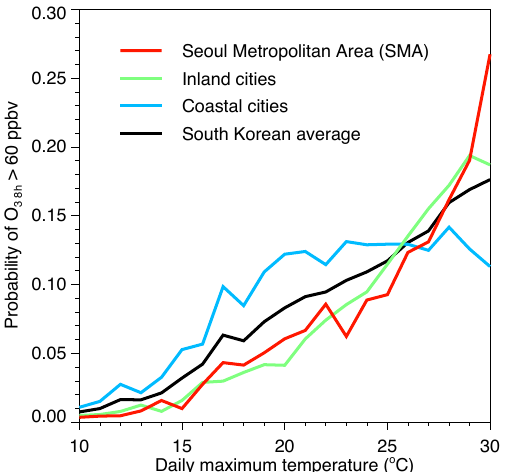
Figure 8. Probabilities of O 3 exceedances in the given range of daily maximum temperature ( T max ) that O 38h will exceed the air quality standard of South Korea